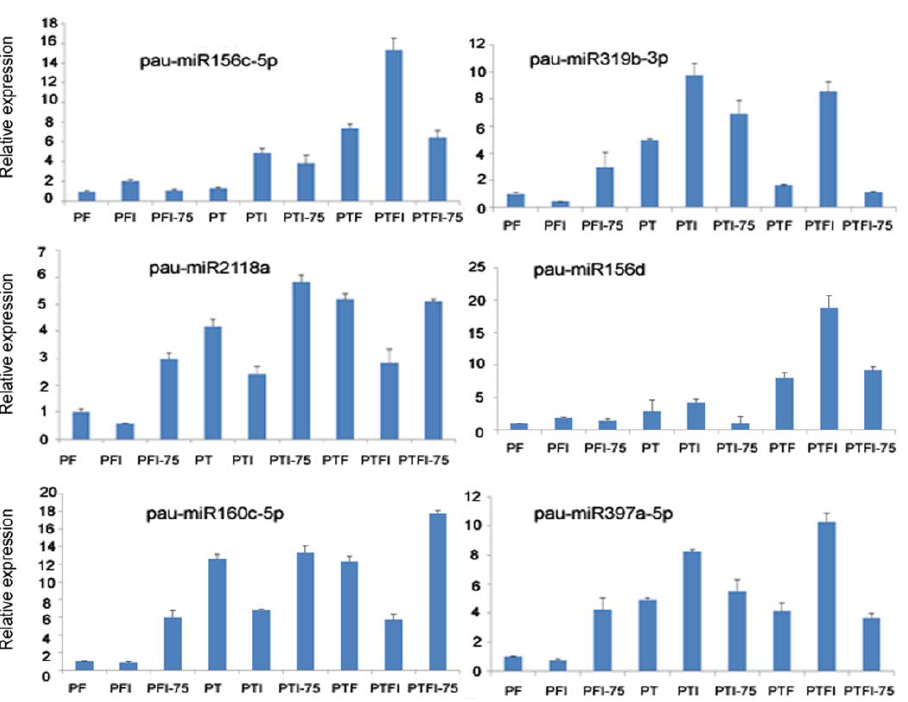
Figure 4. qPCR analysis of the expression level of the miRNAs.